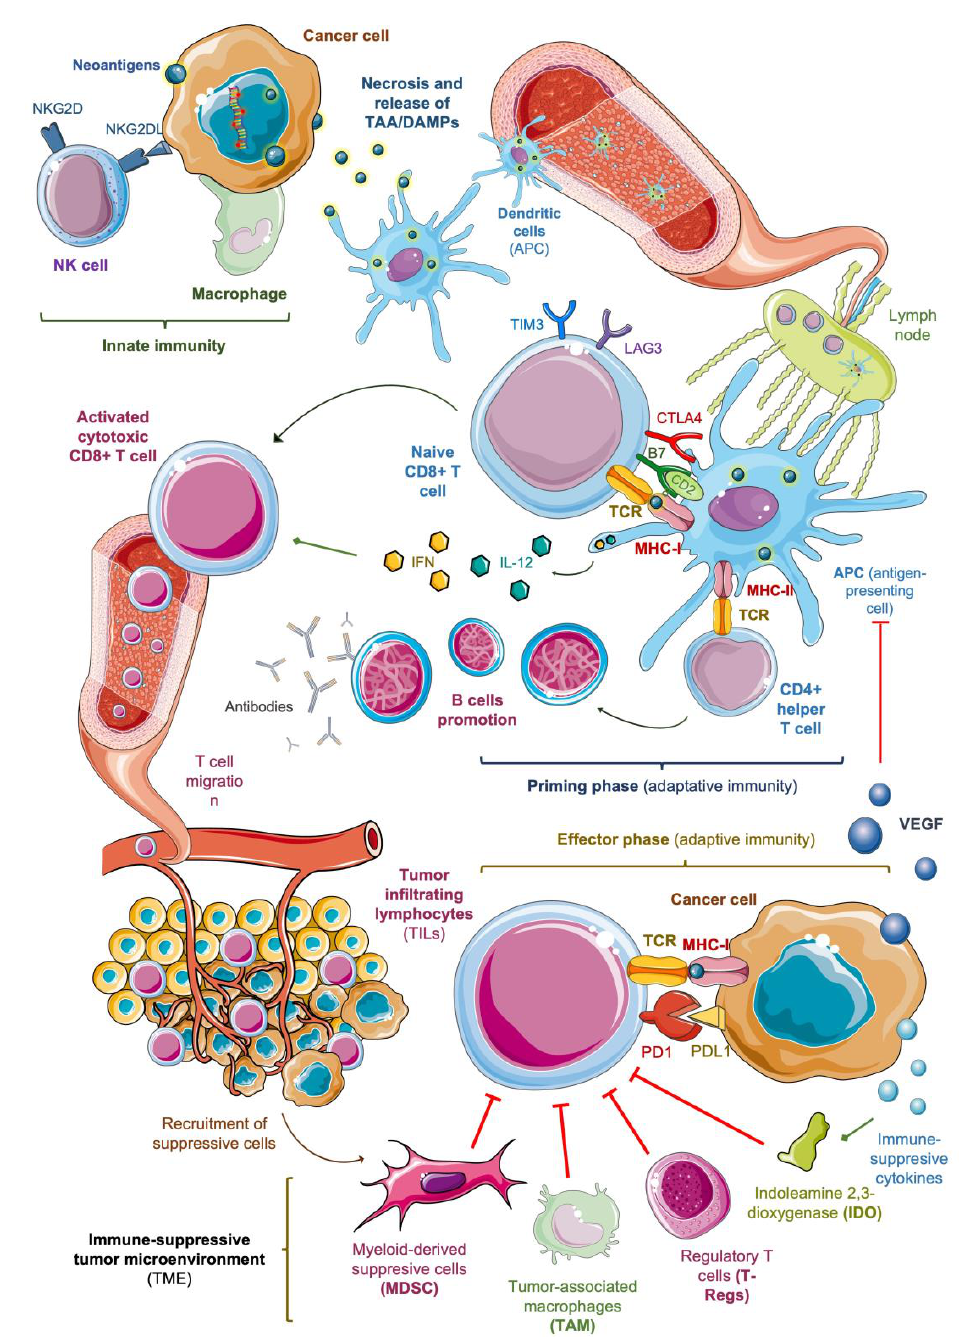
Figure 1. Mechanisms of anti-tumor response and potential immune biomarkers in solid tumors. NK: natural killer; TAA: tumor-associated antigen; DAMPs: damage-associated molecular patterns; TCR: T cell receptor; MHC: major histocompatibility complex; IL-12: interleukin-12; IFN: interferons; VEGF: vascular endothelial growth